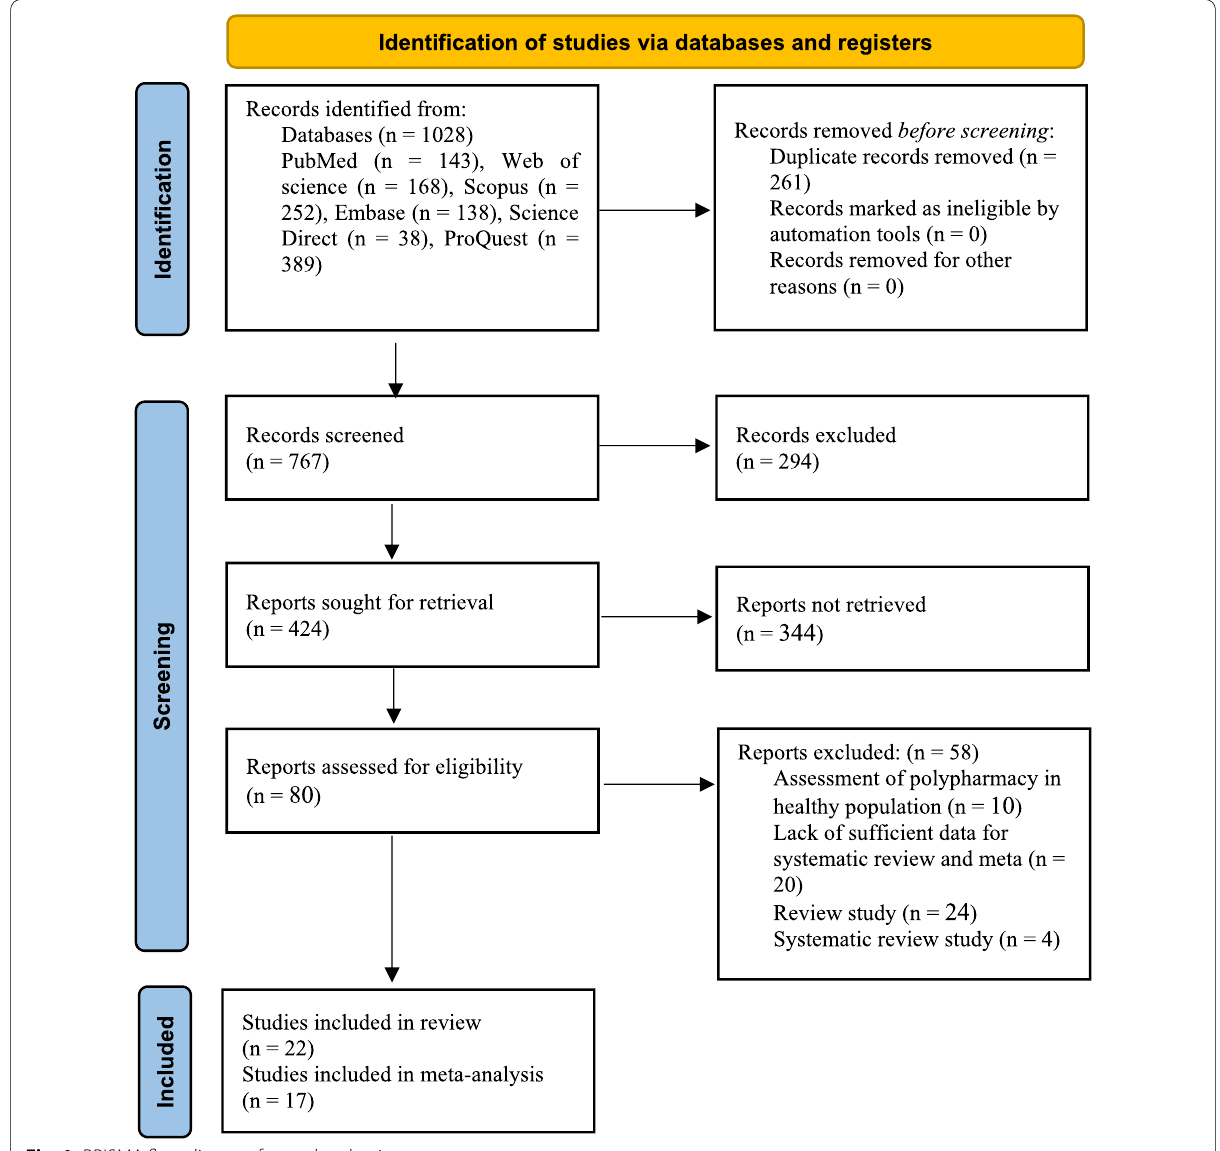
Fig. 1 PRISMA flow diagram for study